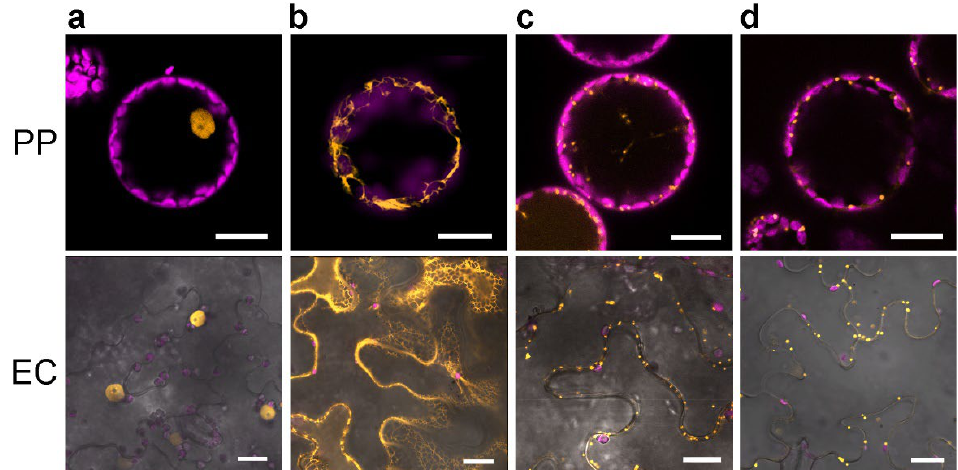
Figure 3. Subcellular localization of proteins located within the nucleus ( a ), endoplasmic reticulum ( b ), Golgi apparatus ( c ), and peroxisomes ( d ). ( a ) HTA6–mCherry. ( b ) WAK2(1-30)–mCherry-KDEL. ( c ) MAN1(1-49)–mCherry. ( d ) mCherry–SKL. Fluorescence of the protein/signal peptide fusion with mCherry is shown in orange, whereas the autofluorescence of chloroplasts is depicted in magenta. To better visualize the location of the respective organelles in epidermal cells, the bright field image was added. PP—protoplast, EC—epidermal cell. Bars represent 20 µ m in all